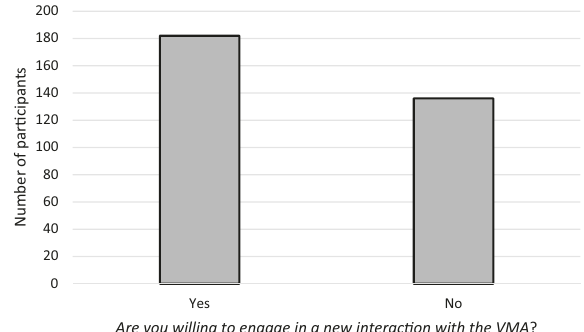
Fig. 2 Distribution of outpatients regarding their perceived engagement with the VMA.